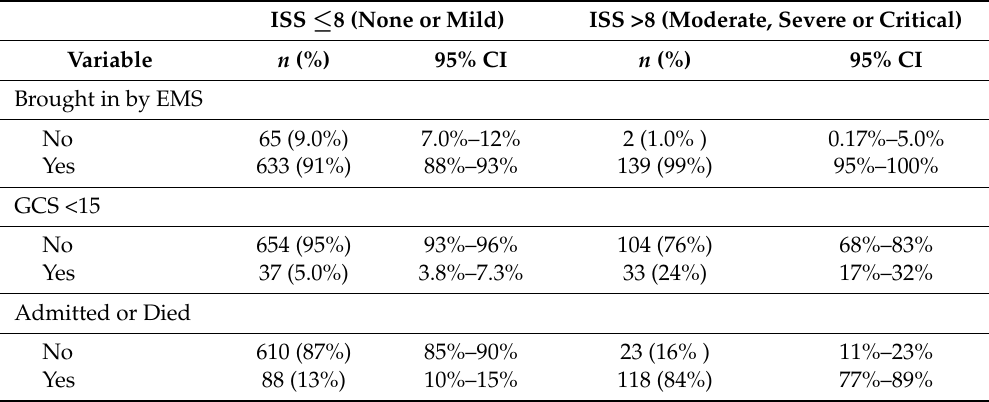
Table 2. Stratified analysis of process and outcome variables by ISS categories.